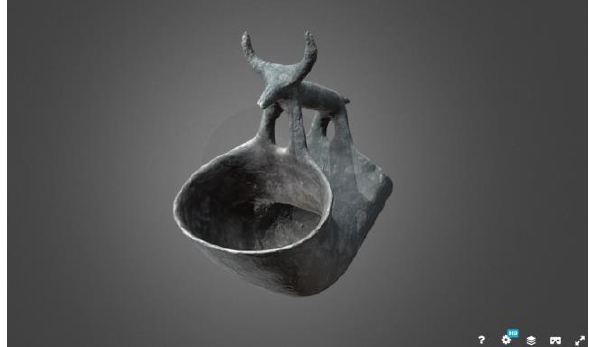
Figure 5: A 3D model of the askos vessel uploaded on sketchfab platform; P98_inv11549